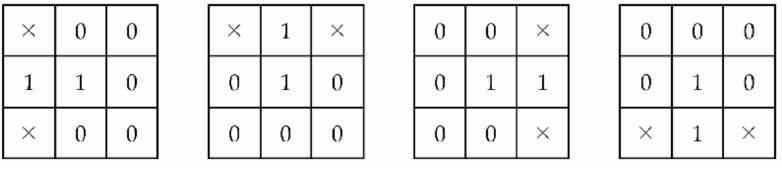
Figure 6. Structure